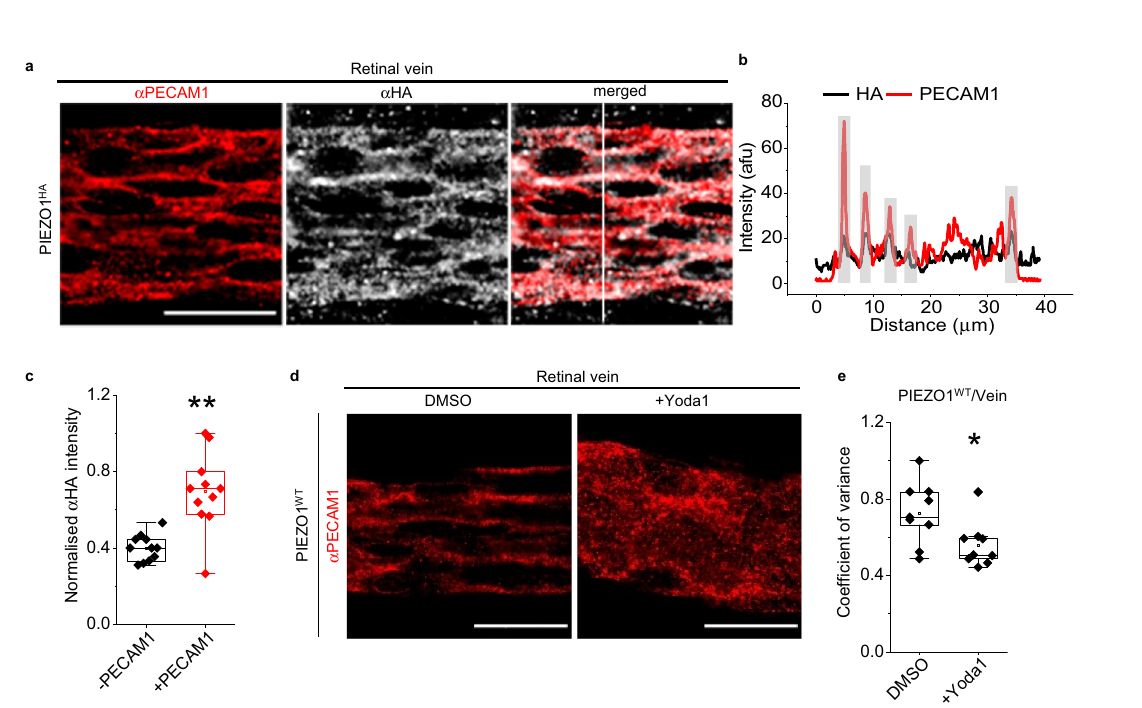
Fig. 1 Genetically engineered PIEZO1 HA has comparable activity to wild-type PIEZO1 (PIEZO1 WT ) in mice. a Example current recording from an outside- out patch from freshly isolated endothelium of second-order mesenteric artery of PIEZO1 HA mouse. Holding potential, − 70 mV. Fluid fl ow, 20 μ l.s − 1 . Gadolinium (III) ion (Gd 3 + ), 10 μ M. Currents on expanded time-base are shown below in which c indicates the closed channel current level and o1, o2 and o3 the open channel current levels for simultaneous openings of up to 3 channels. b Mean ± s.e.mean unitary current amplitudes for fl ow-induced ion channel activity as in a plotted against holding voltage ( n = 7 independent recordings). The fi tted line indicates unitary conductance of 25.9 pS. c Channel activity indicated by NP o (number of channels per patch × probability of channel opening) for experiments of the type exempli fi ed in a for no fl ow and fl ow conditions with or without Gd 3 + . Individual data points for each experiment are represented by symbols, superimposed on which are the mean ± s.e.mean values (** P Flow = 0.0001703, ** P Flow + Gd3 + = 0.000165, n = 7 for each group). d Example trace of membrane potential measured from freshly isolated endothelium of second-order mouse mesenteric artery of PIEZO1 HA mouse. Fluid fl ow, 20 μ l.s − 1 . e Individual data points representing membrane potentials before and after fl ow as exempli fi ed in d (*** P = 0.00000343) ( n = 7). Data points connected by a line were from the same recording. f Example current recording from an outside-out patch from freshly isolated endothelium of second-order mesenteric artery of PIEZO1 WT mouse. Holding potential, − 70 mV. Fluid fl ow, 20 μ l.s − 1 . Gadolinium (III) ion (Gd 3 + ), 10 μ M. g Mean ± s.e.mean unitary current amplitudes for fl ow-induced ion channel activity as in b plotted against holding voltage ( n = 6 independent recordings). The fi tted line indicates unitary conductance of 25.9 pS. h Channel activity indicated by NP o (number of channels per patch × probability of channel opening) for experiments of the type exempli fi ed in f for no fl ow and fl ow conditions with or without Gd 3 + . Individual data points for each experiment are represented by symbols, superimposed on which are the mean ± s.e.mean values (** P Flow = 0.000141, ** P Flow + Gd3 + = 0.000241, n = 6 for each group). i Example trace of membrane potential measured from freshly isolated endothelium of second-order mouse mesenteric artery of PIEZO1 WT mouse. Fluid fl ow, 20 μ l.s − 1 . j Individual data points representing membrane potentials before and after fl ow as exempli fi ed in i ( P = 0.0000375, n = 6). Data points connected by a line were from the same recording. k Table of data comparing values from PIEZO1 HA mouse and PIEZO1 WT mouse, (mean ± s.e.m.). NS indicates no statistically signi fi cant difference between PIEZO1 HA and PIEZO1 WT . For the outside-out patch and membrane potential recordings, the external solution consisted of: 135 mM NaCl, 4 mM KCl, 2 mM CaCl 2 , 1 mM MgCl 2 , 10 mM glucose and 10 mM HEPES (titrated to pH 7.4 with NaOH). The patch pipette contained: 145 mM KCl, 1 mM MgCl 2 , 0.5 mM EGTA and 10 mM HEPES (titrated to pH